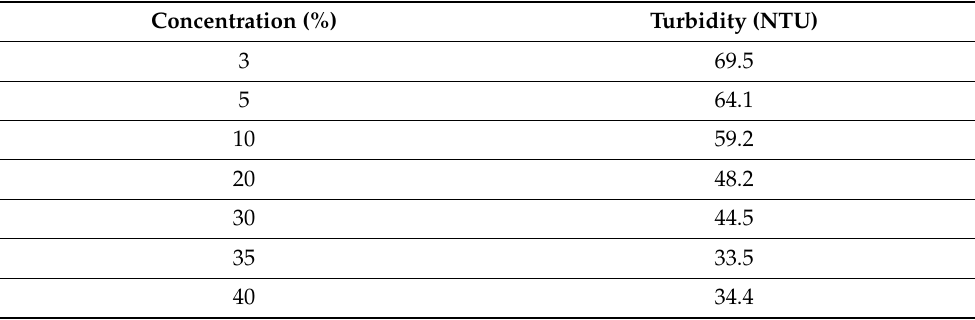
Table 2. Turbidity values for as-synthesized surfactant with the presence of EGME at different concentrations.